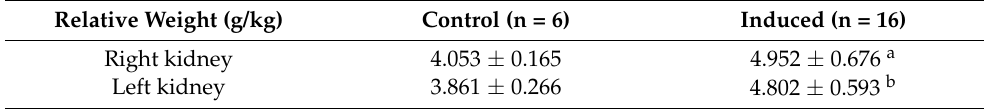
Table 2. Mean relative weight of rats’ kidneys after